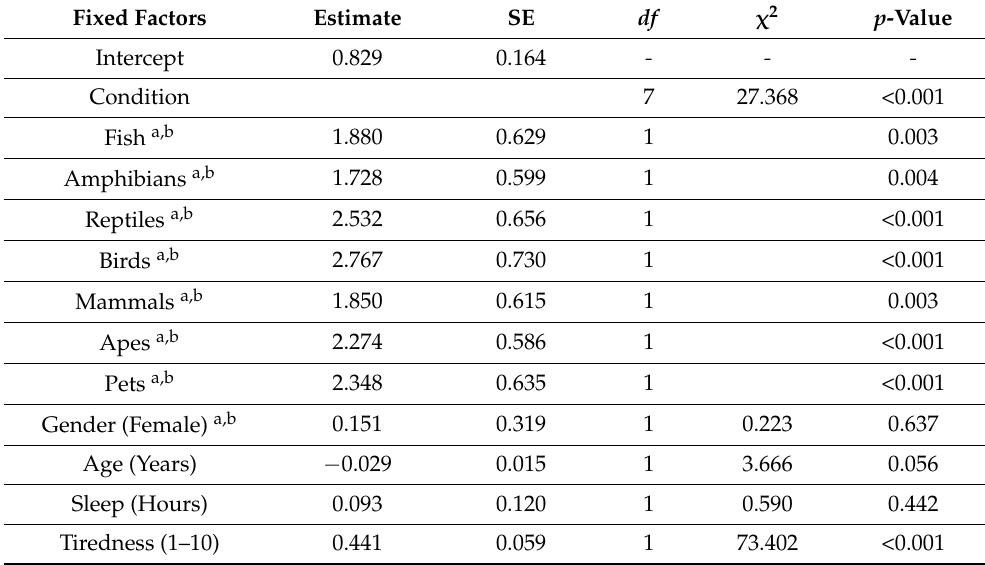
Table 2. Estimated parameters (Estimate), Standard Error (SE), and results of the likelihood ratio tests ( χ 2 ) for the binomial logit distribution.